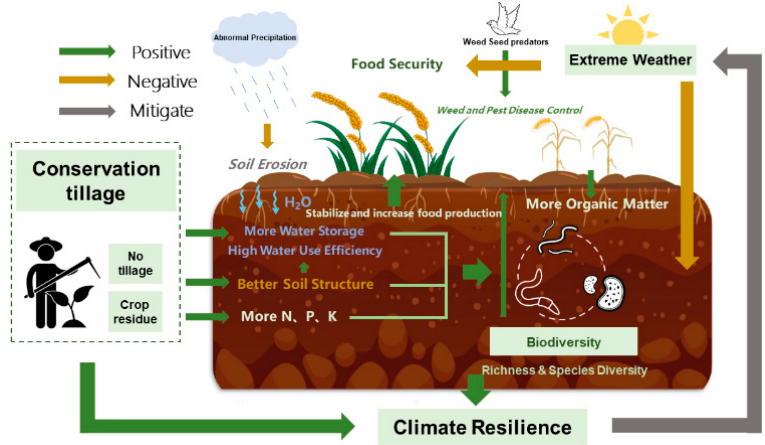
Figure 1. How Conservation Tillage Enhances Climate Resilience in Agriculture.